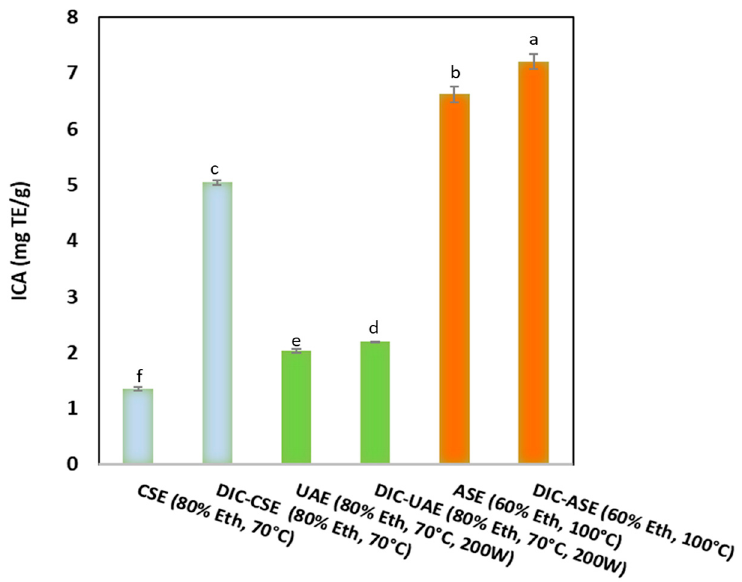
Figure 3. Iron chelating activity (mg EDTA/g DM) of orange byproduct extracts obtained for CSE, UAE, and ASE with or without DIC pretreatment. Values followed by the same letter are not statistically significant according to Tukey’s multiple range test at a significance level of p < 0.05.